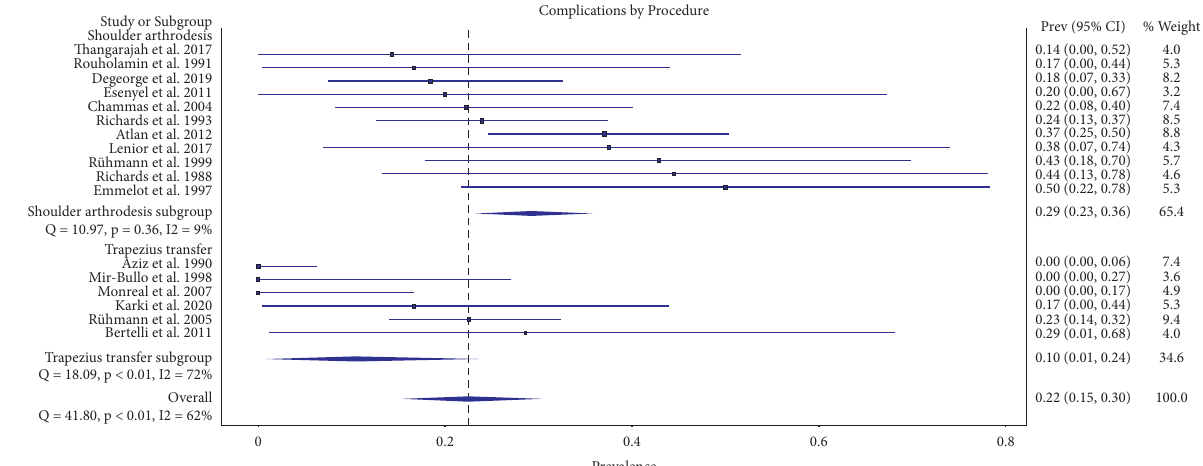
Figure 2: Forest plot illustrating the proportions of complications for shoulder arthrodesis versus upper trapezius transfer.